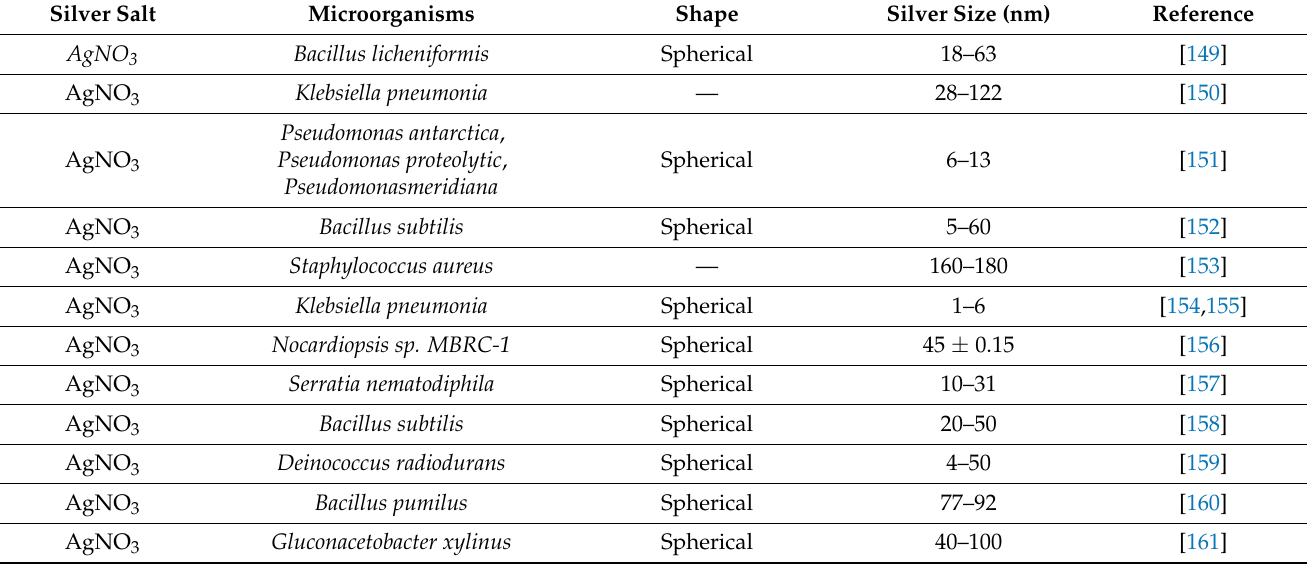
Table 8. Synthesis of AgNPs s using